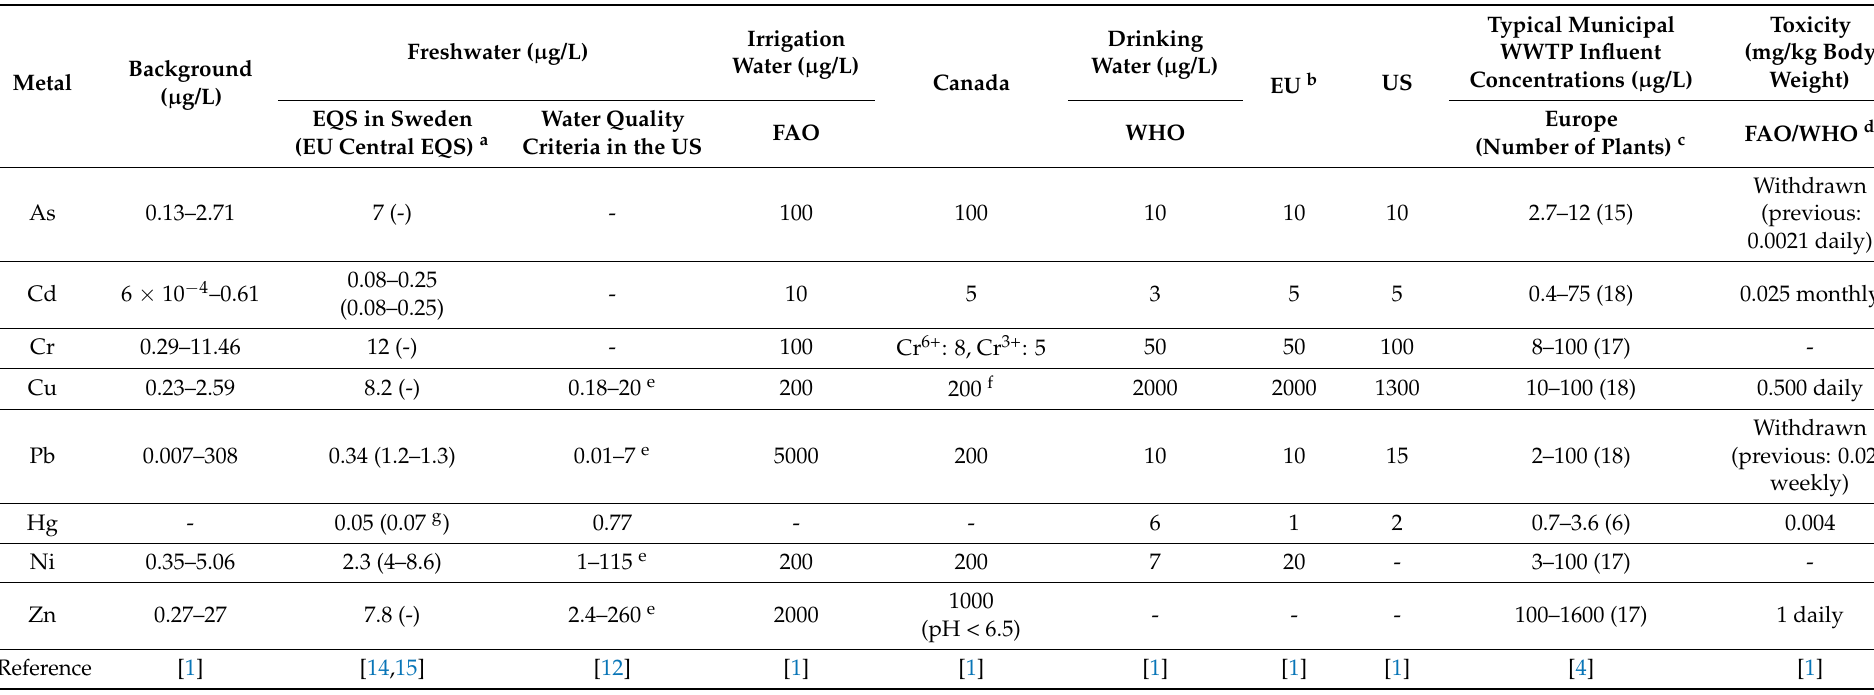
Table 1. Heavy metal concentrations in municipal WWTP influents compared to concentrations in natural water (background) and regulation/standards for: freshwater (EU/US); irrigation water (Food and Agriculture Organization of the United Nations (FAO)/Canada); drinking water (World Health Organization (WHO)/EU/US); and toxicity